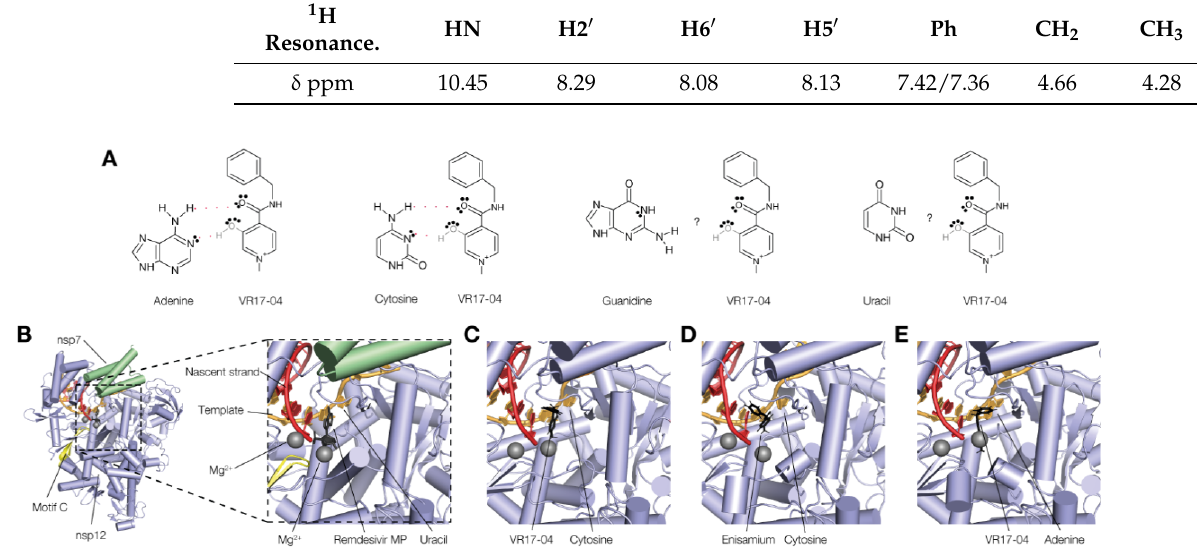
Figure 4. Molecular docking of VR17-04 binding into the nsp12/7/8 complex. ( A ) Schematic of putative hydrogen bond formation between cytosine and adenine bases with VR17-04. ( B ) Structure of the SARS-CoV-2 nsp12/7/8 complex bound to RNA and remdesivir monophosphate. Rendering based on PDB 7bv2. ( C ) Docking of VR17-04 binding to cytosine in nsp12 active site. ( D ) Docking of enisamium binding to cytosine in nsp12 active site. ( E ) Docking of VR17-04 binding to adenine in nsp12 active site.